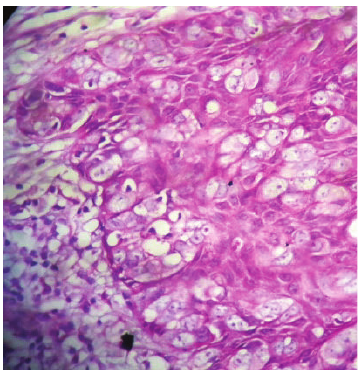
Figure 5: HE, 400x, Paget cells in the basal layer, some with melanic